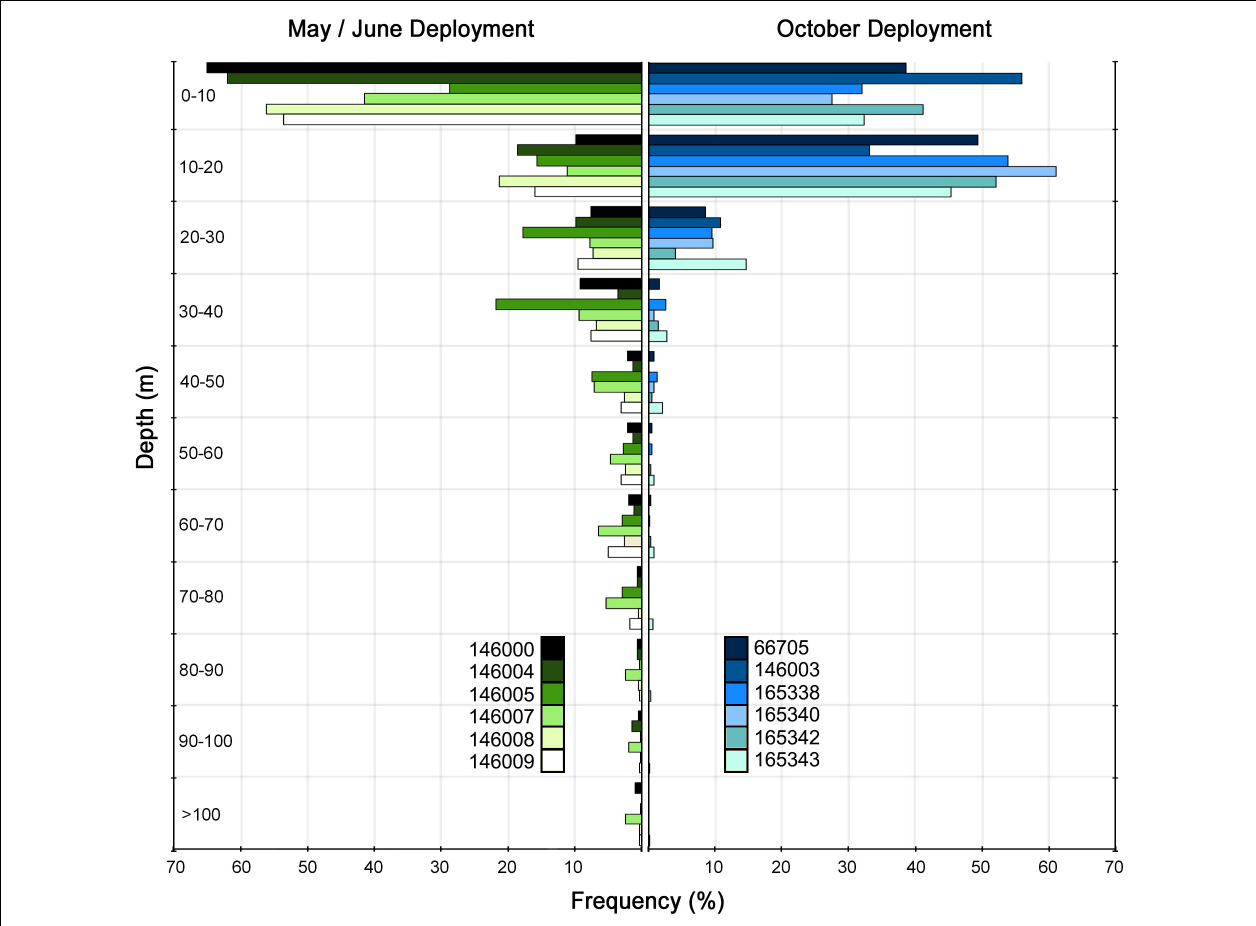
FIGURE 4 | Depth occupation frequency grouped by deployment period for Mobula alfredi ( n = 12) tagged off the mid-west Australian coast. Depth observations are from recovered PSAT time-series and recovered archival tag data.